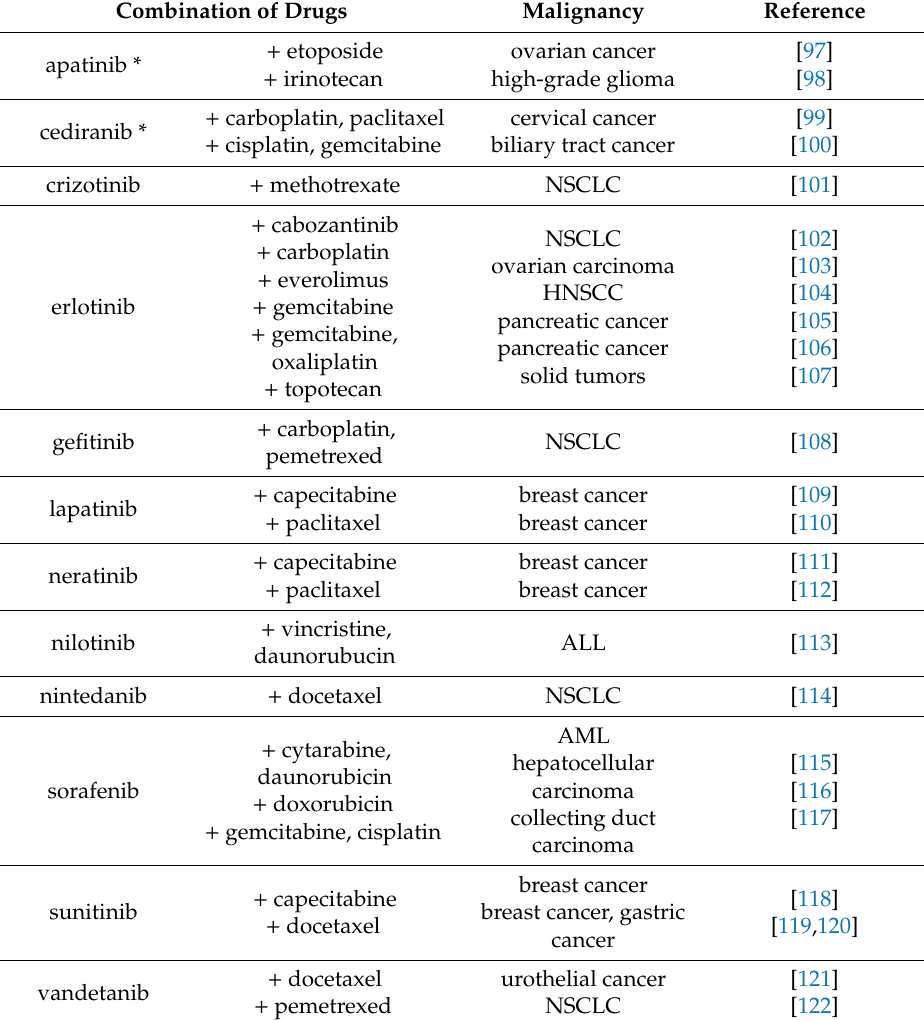
Table 4. Combinational strategies using TKIs in clinical